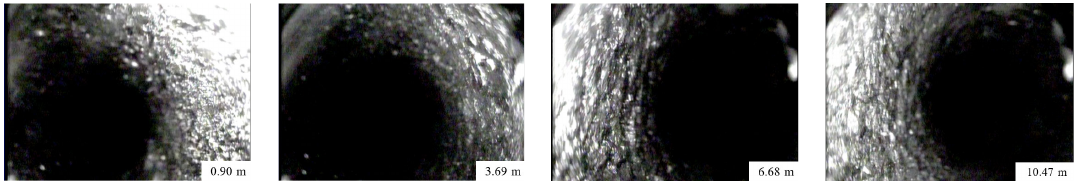
Figure 19. Large ‐ diameter borehole drilling rig. Figure 19. Large-diameter borehole drilling rig.